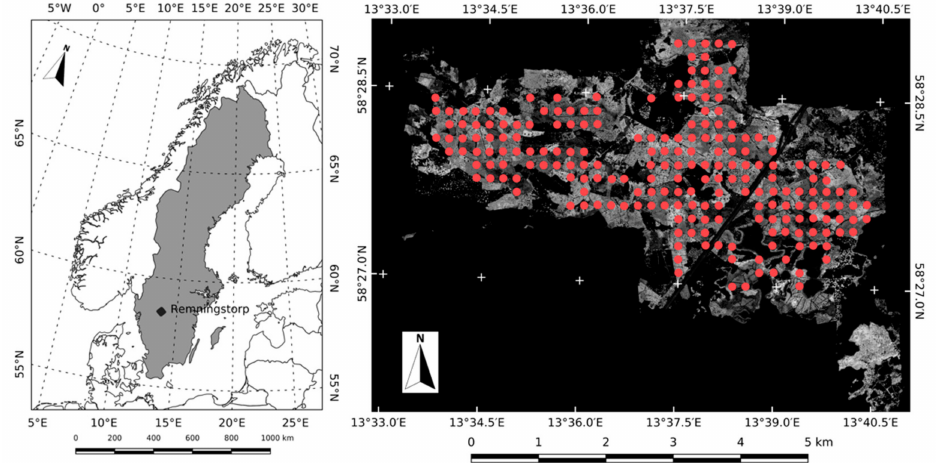
Figure 1. Location of the Remningstorp test site in Sweden ( left ). Circular plots established in Remningstorp in 2010 with a LiDAR canopy surface model in the background ( right )